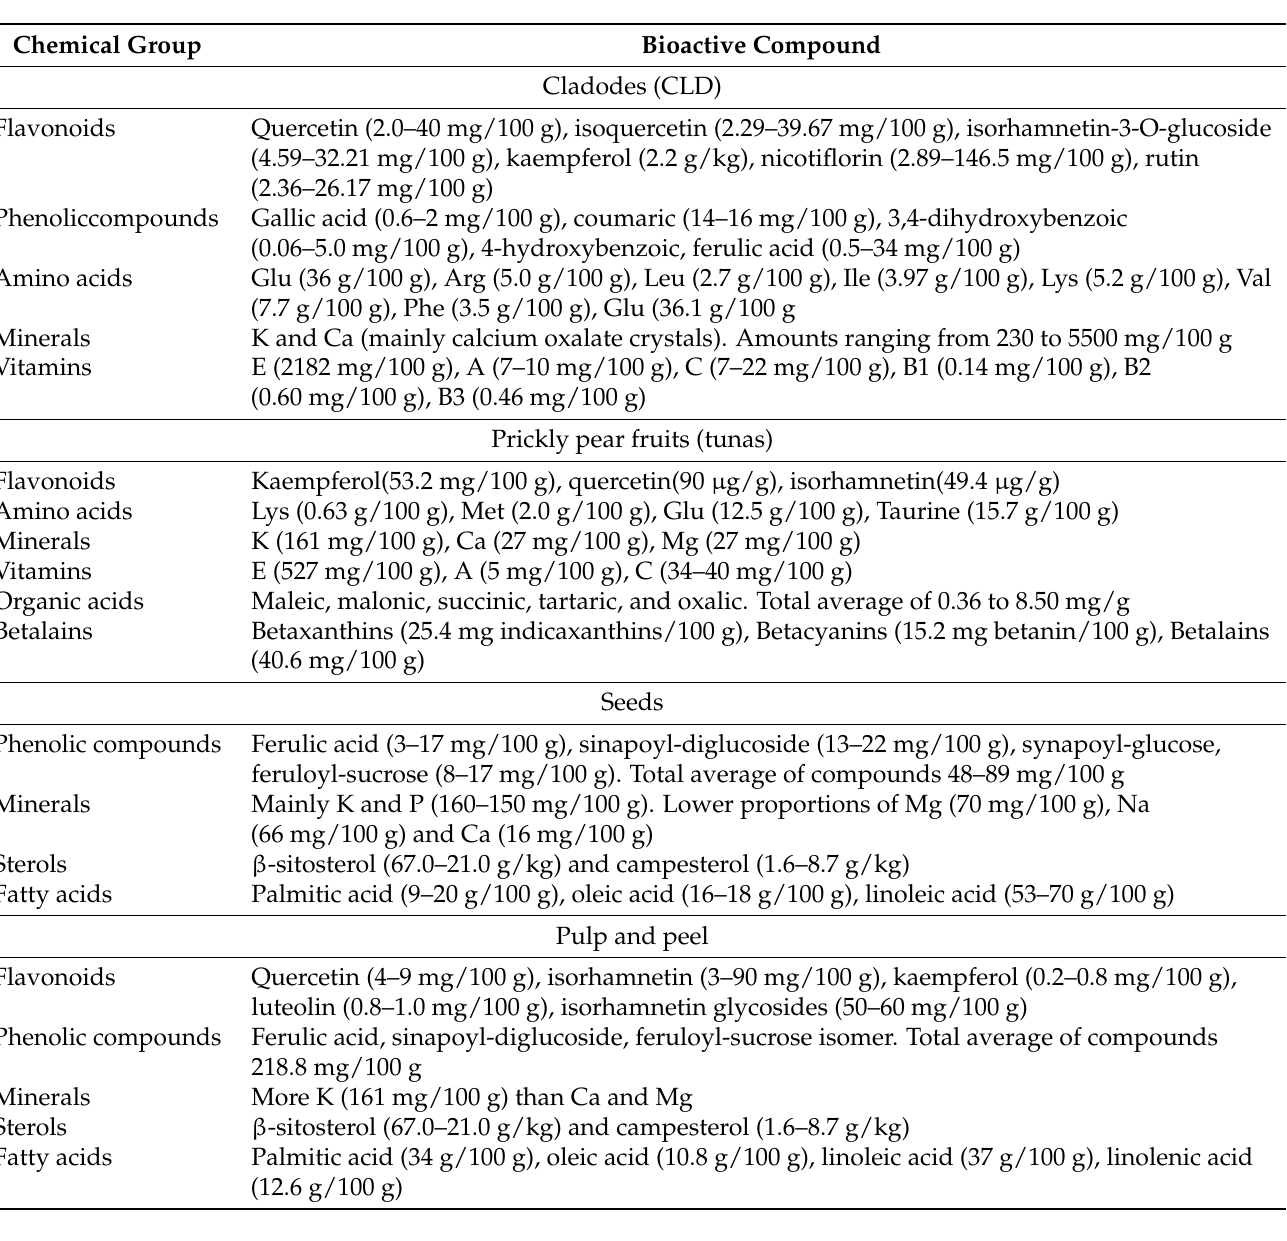
Table 1. Main bioactive compounds in different anatomical parts of O.